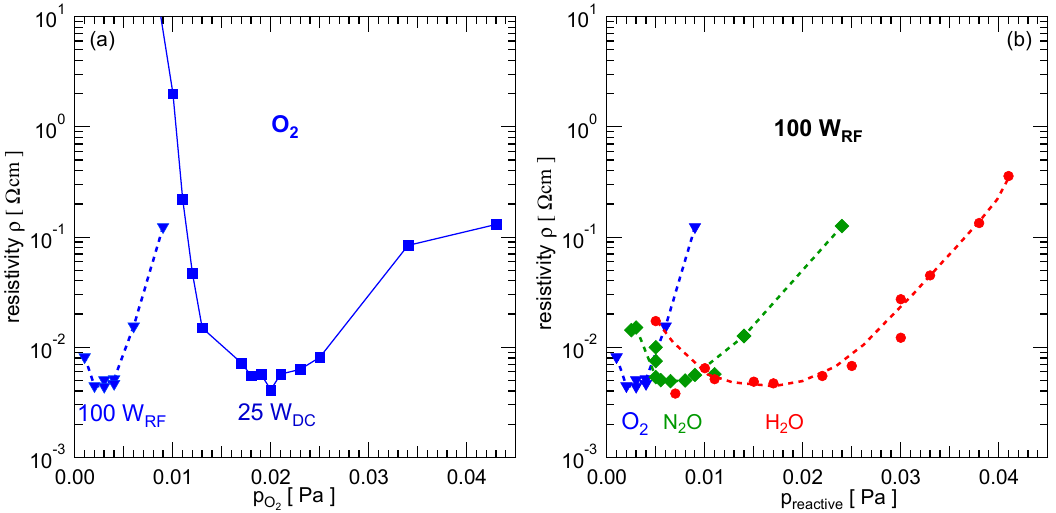
Figure 4. ( a ) Partial pressure dependence of the resistivity for the reactive gas O 2 for DC and RF plasma excitation. The deposition rate is the same in both cases (R ≈ 18 nm / s). ( b ) Dependence of the resistivity on the partial pressure of the reactive gases O 2 , N 2 O and H 2 O for RF plasma excitation. Deposition parameters: P DC = 25 W, P RF = 100 W, p total = 0.5 Pa, RT deposition.